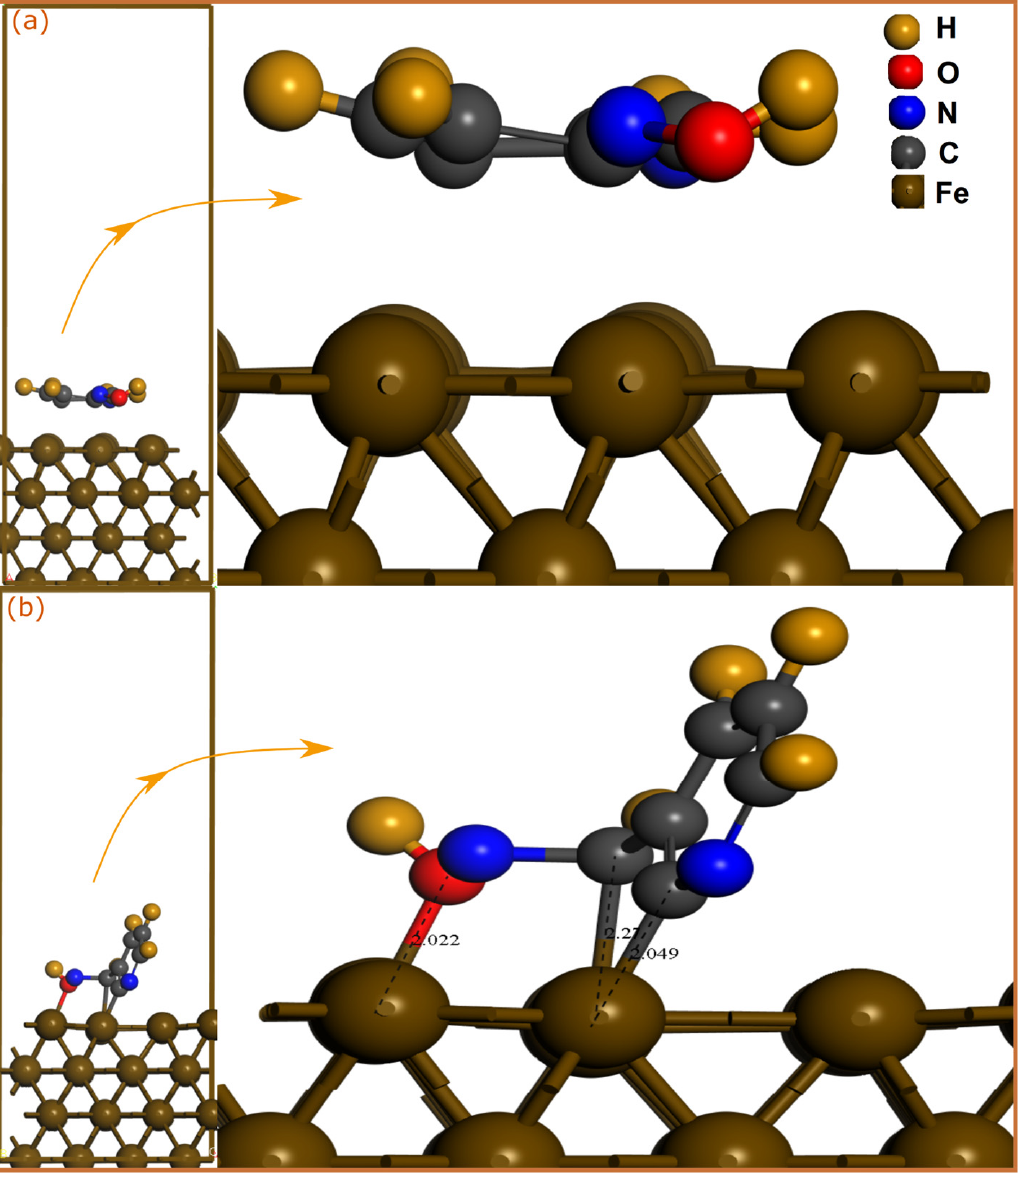
Figure 1. SCC-DFTB-optimized adsorption geometries of neutral and protonated 2POH molecules on Fe(110) surface; ( a ) neutral and ( b ) protonated forms. Bond distances are in Å.